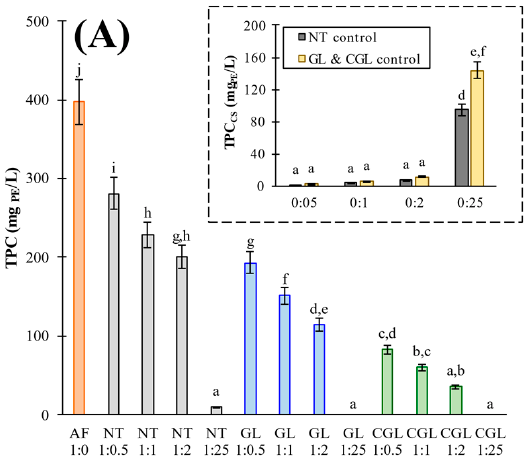
Foods 2022 , 11 , x FOR PEER